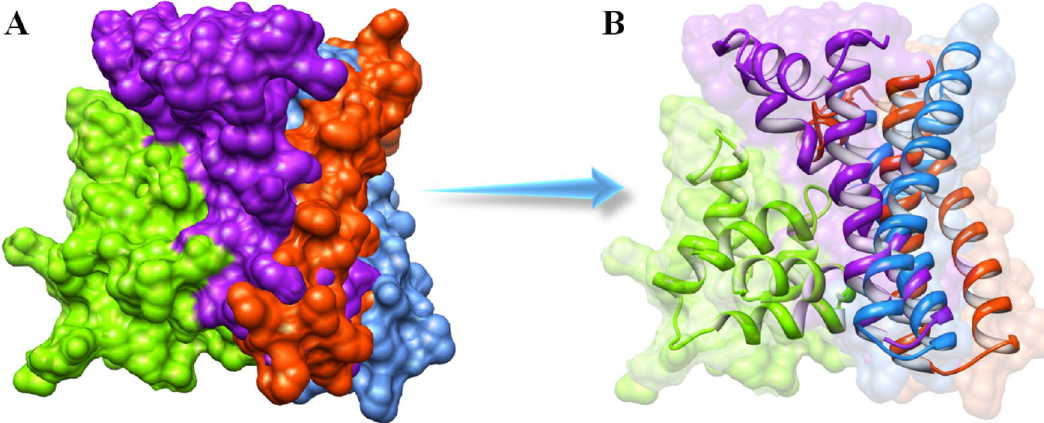
Figure 6. ( A , B ). The binding conformations of MADD and TNFR1 death domains. The TNFR1 death domain is represented in green color, whereas the MADD death domain of three docked complexes is highlighted in purple, blue and orange colors